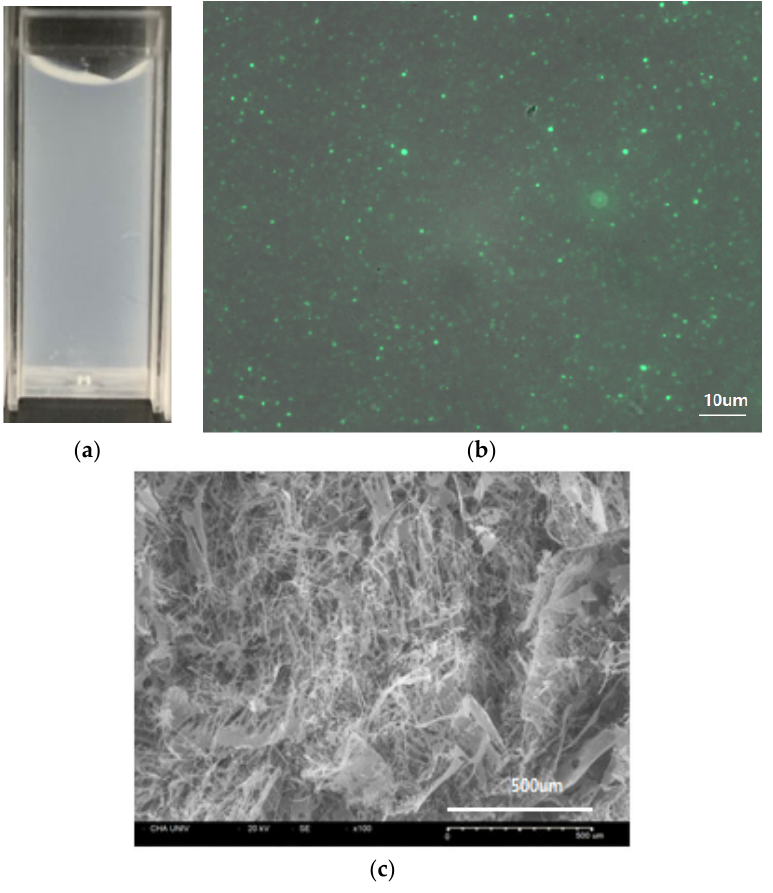
Figure 2. Morphology of HWGA ‐ SA bFGF complex coacervates. ( a ) Photographic image of bFGF coacervates, ( b ) fluorescence microscope image of FITC ‐ bFGF coacervate, and ( c ) SEM image of a cross ‐ section of freeze ‐ dried